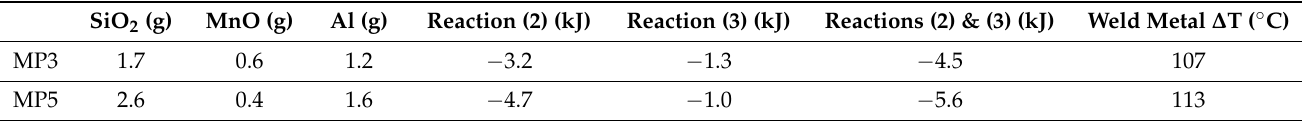
Table 7. Exothermic heat from aluminium reduction reactions (2) and (3).